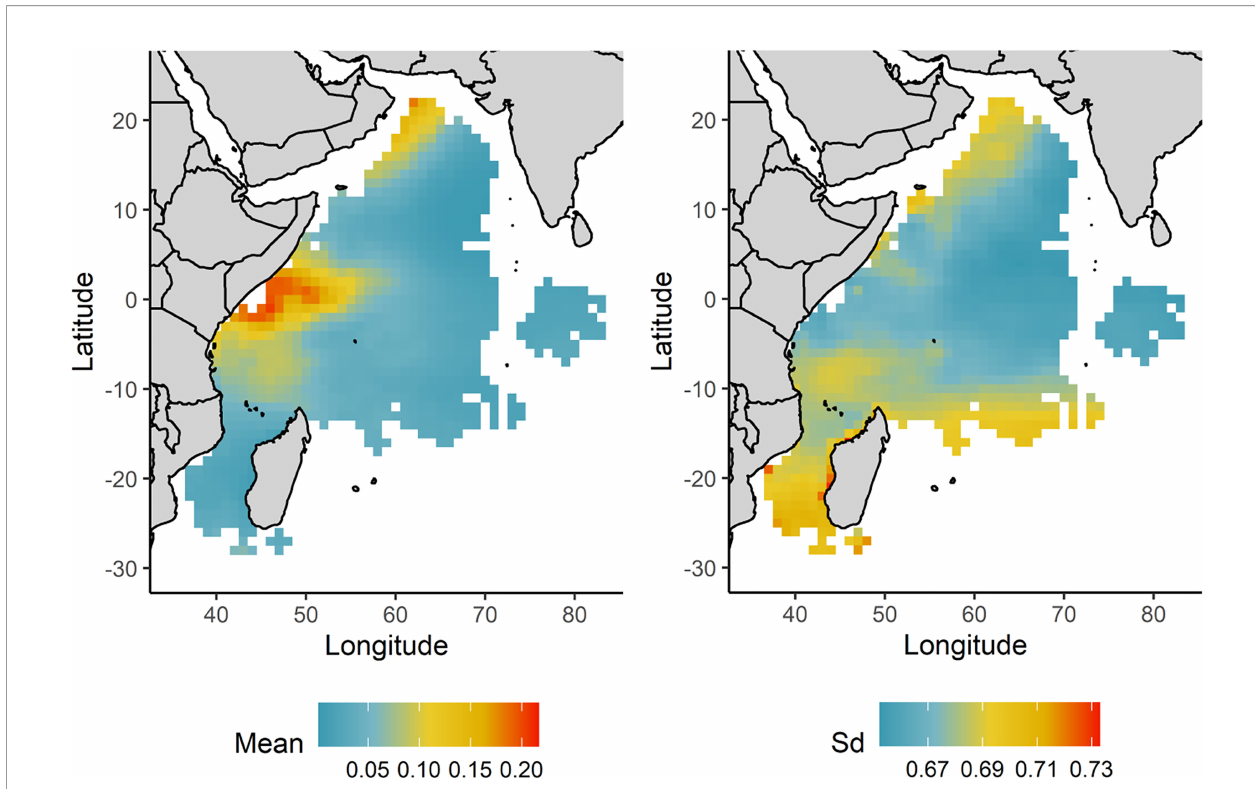
FIGURE 6 | Spatial distribution of the mean and standard deviation (Sd) predicted catch probability of an oceanic whitetip shark over 2010-2020 and across the fi shing grounds of the tropical tuna purse seine fi shery in the western Indian Ocean. For predictions the FAD fi shing technique was used as